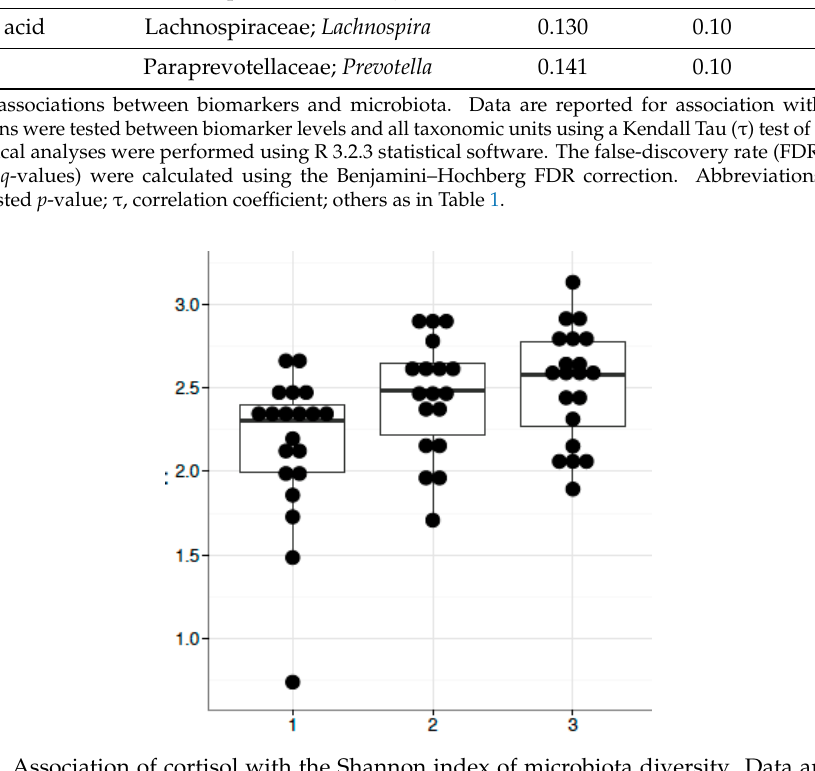
Figure 2. Association of cortisol with the Shannon index of microbiota diversity. Data are: Y -axis is Shannon index, X -axis: 1, 2, 3 are Tertiles (T) of cortisol level, p = 0.006 for T1 versus T3 by Mann–Whitney test.